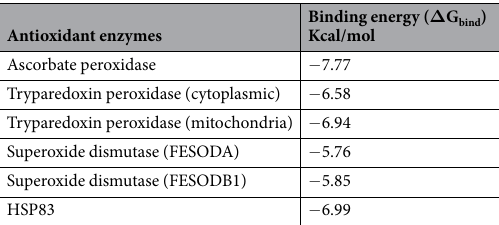
Antioxidant enzymes